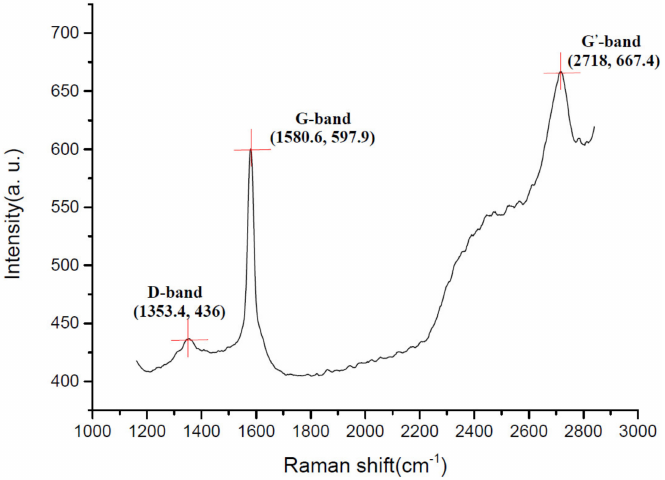
Figure 9. Raman spectrum for NDG.